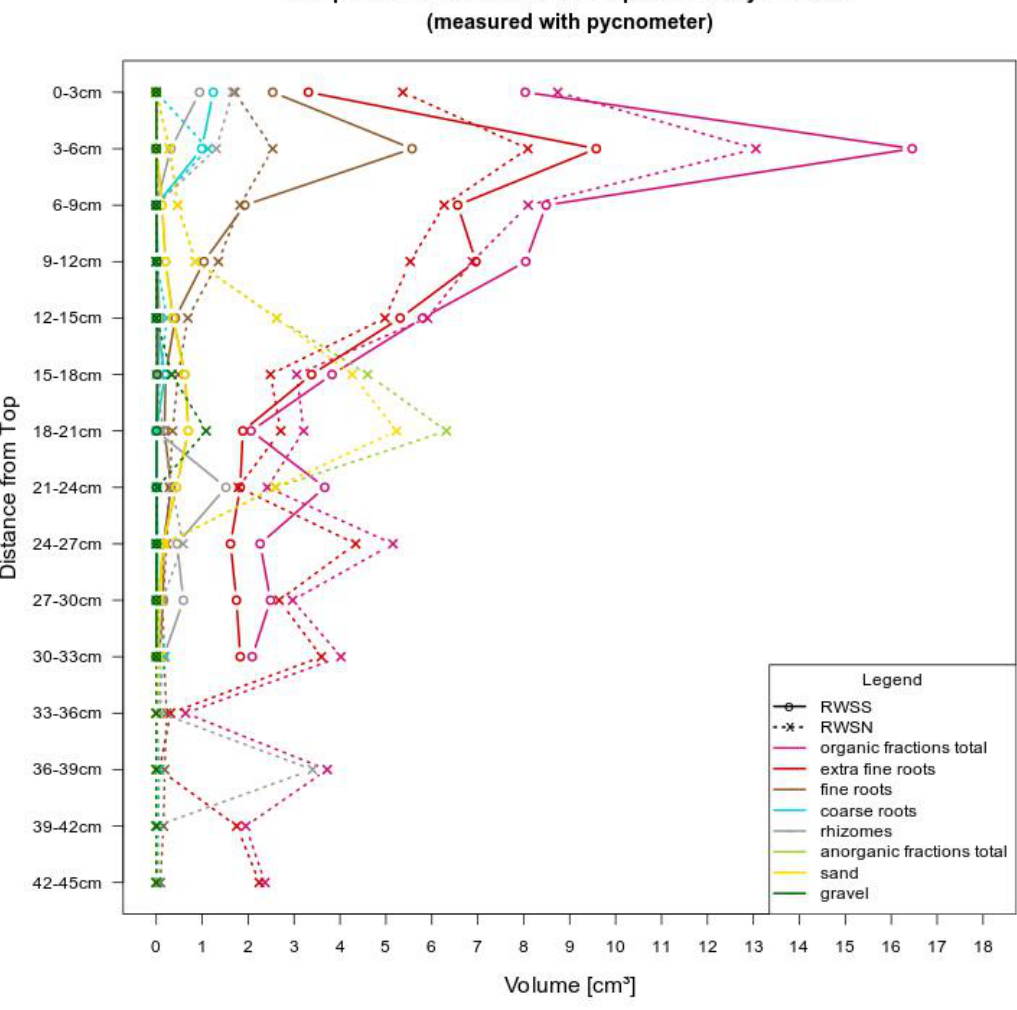
Figure 8. Volume (per cm depth) of washed out root and clastic fractions in RWSN and RWSS as measured with a pycnometer.